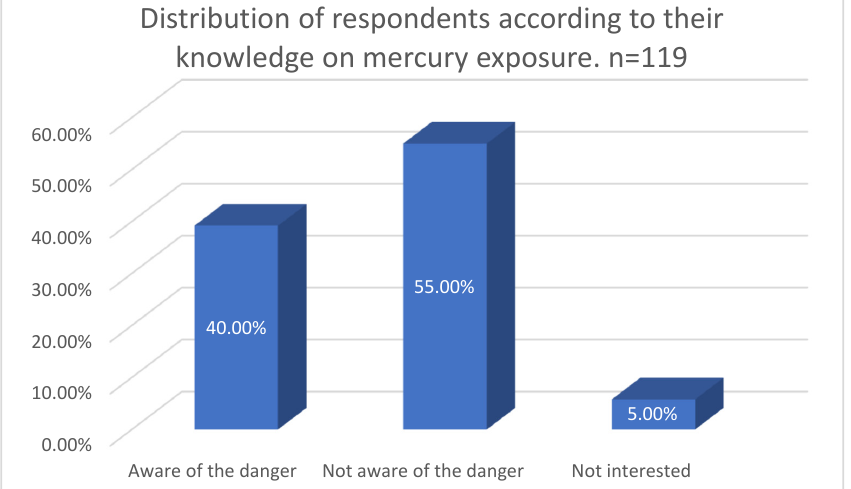
Figure 5. Distribution of respondents according to their knowledge on mercury exposure associated with fish consumption.